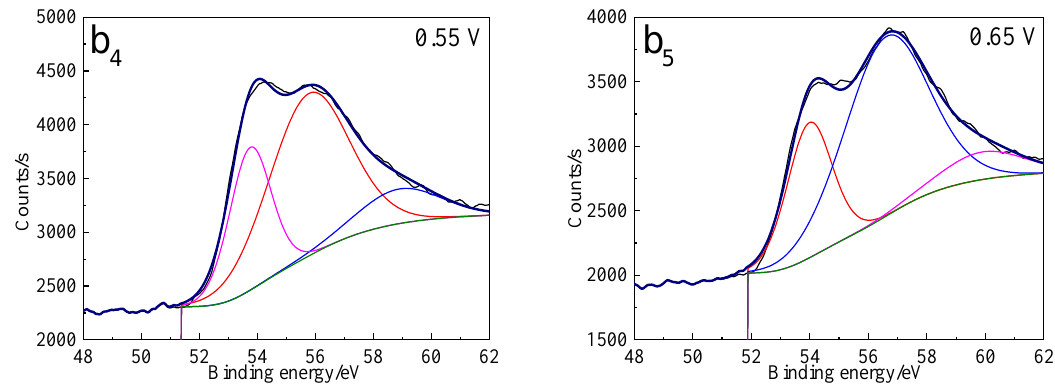
Figure 12. XPS spectra of Fe peaks of bornite surface after treating by different potential of 0, 0.3, 0.45, 0.55, 0.65 V, respectively: ( a ) Fe 2p peak; ( b 1 – b 5 ): Fe 3p peak (Implemented on the model of ESCALAB 250Xi of Al Kα X-ray source with 20 eV constant pass energy and 0.1 eV/step; Fitted by Thermo Avantage 5.52, C 1s 284.8 eV as reference, Shirley method, Gaussian-Lorentzian function).